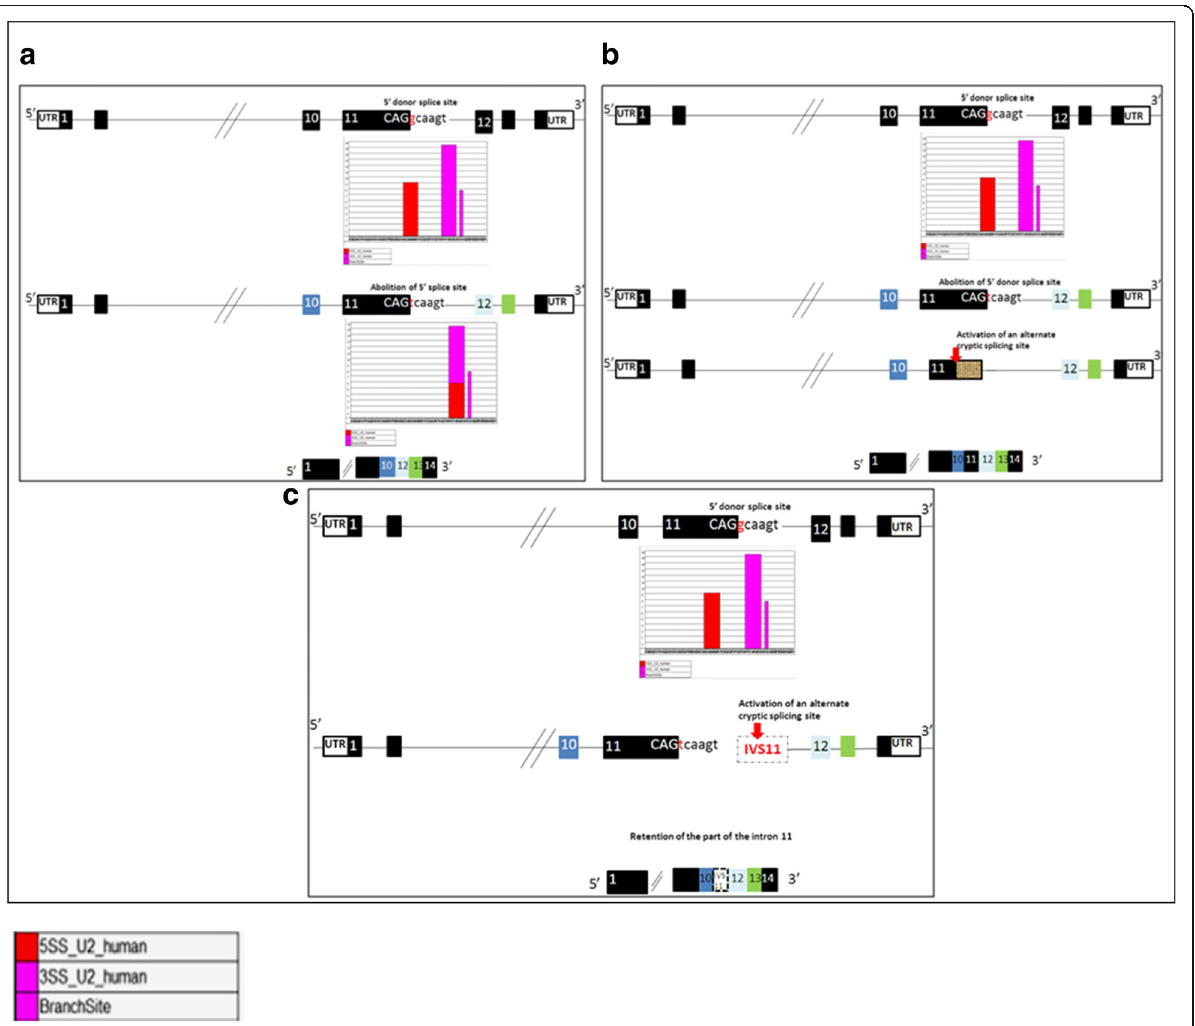
Fig. 3 Effects of IDUA splice site mutation. a Mutation c.1650 + 1G > T, which abolies a splice donor (GT) within intron 11, resulting in skipping of the exon 11. b Mutation c.1650 + 1G > T, which creates an alternate cryptic splicing site, resulting in the deletion of 169 nucleotides at the end of the exon 11 giving a new size of exon 11 about 135 bp. c Mutation c.1650 + 1G > T which retains the part of the intron